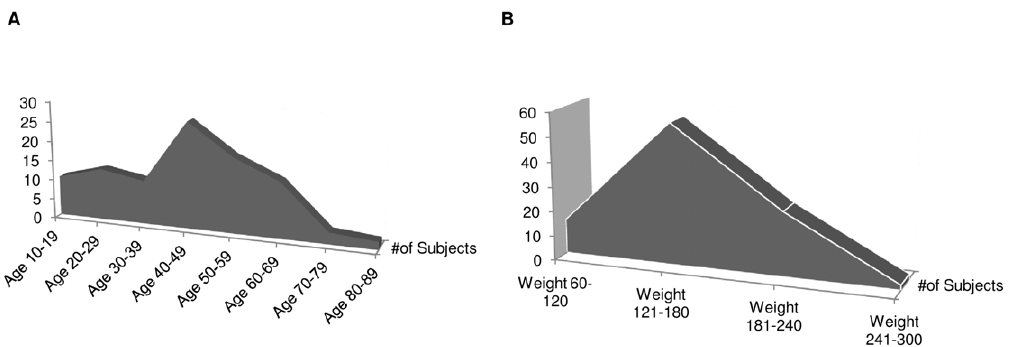
Figure 1. Distribution of age and weight classification of the study group. The graphs depict a non-biased age ( A ) and weight distribution ( B ) for the subjects evaluated for the study.